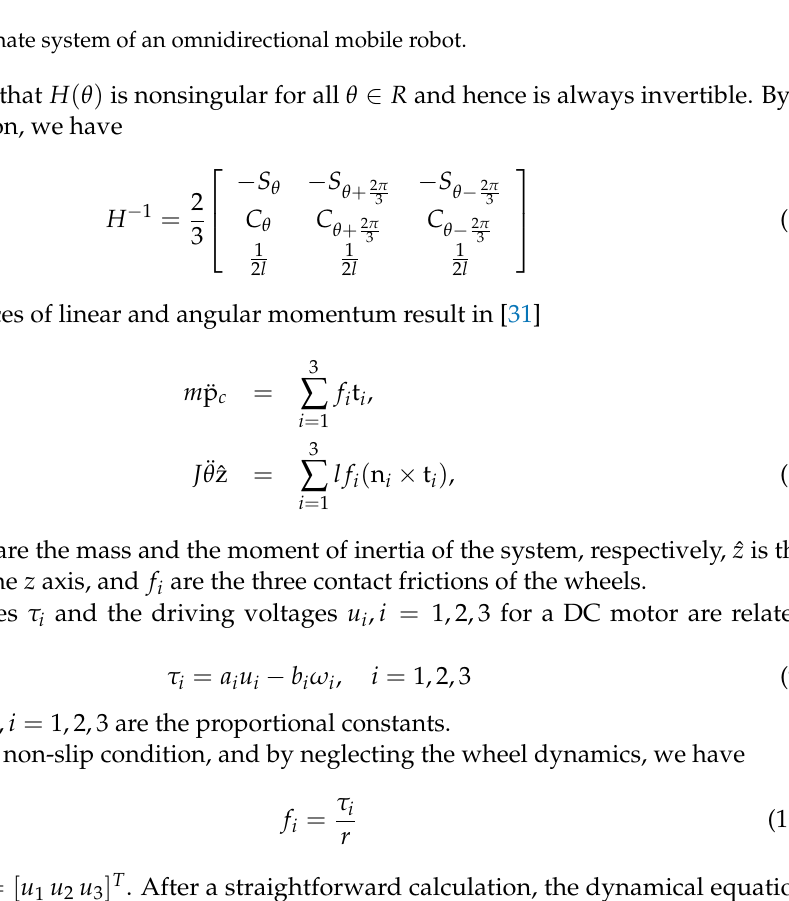
Figure 2. Coordinate system of an omnidirectional mobile robot